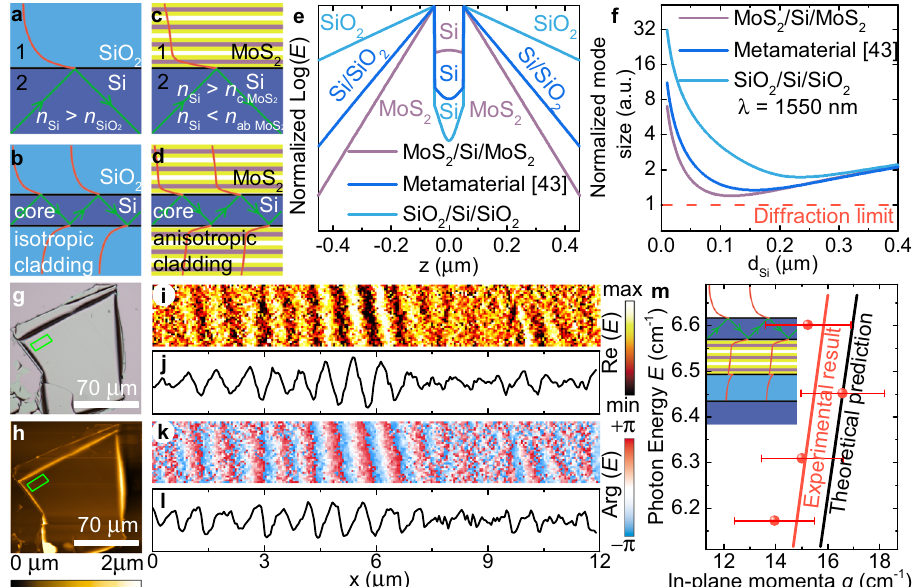
Fig. 5 Transparent sub-diffraction optics. a Traditional total internal re fl ection with two isotropic media: above the critical angle, the light is re fl ected from the interface giving a decaying wave for a lower refractive index medium. b The decaying wave penetrates low refractive index material resulting in strong cross-talk between neighboring waveguides and limits the current on-chip photonics. c Relaxed total internal re fl ection: the out-of-plane dielectric refractive index is less than that of isotropic material, while the high in-plane refractive index provides fast decay of electric fi eld amplitude in the fi rst medium. d Anisotropic material gives rise to a planar waveguide with strong light con fi nement. The red curves for the a – d schematically show electric fi eld amplitude. e Comparison of electric fi eld distributions for MoS 2 /Si/MoS 2 , metamaterial(SiO 2 /Si)/Si/metamaterial(SiO 2 /Si) 43 systems reveals that giant anisotropy causes giant light compression. f Light con fi nement in MoS 2 /Si/MoS 2 allows for tackling the diffraction limit compared with traditionally used SiO 2 /Si/SiO 2 and recently introduced 43 metamaterial cladding with alternating layers of Si and SiO 2 with silicon as a core. Mode size is normalized to the diffraction limit de fi ned as λ /(2 ∙ n core ). g , h Optical and AFM topography images of the fl ake with 190 nm covered silicon. i – l Near fi eld images, real part Re ( E ) and phase Arg ( E ), with the corresponding line scans of the electric fi eld taken at λ = 1550 nm from the area of g – h indicated by a green rectangular. (s-SNOM images taken at different wavelengths are collected in Supplementary Note 5). m Comparison between theoretical and experimental mode dispersion. The error bars show the uncertainty in the determination of mode in-plane momenta q from near- fi eld images displayed in i – l . The inset is an artistic representation of the investigated system Air/Si (195 nm)/MoS 2 (285 nm)/SiO 2 (285